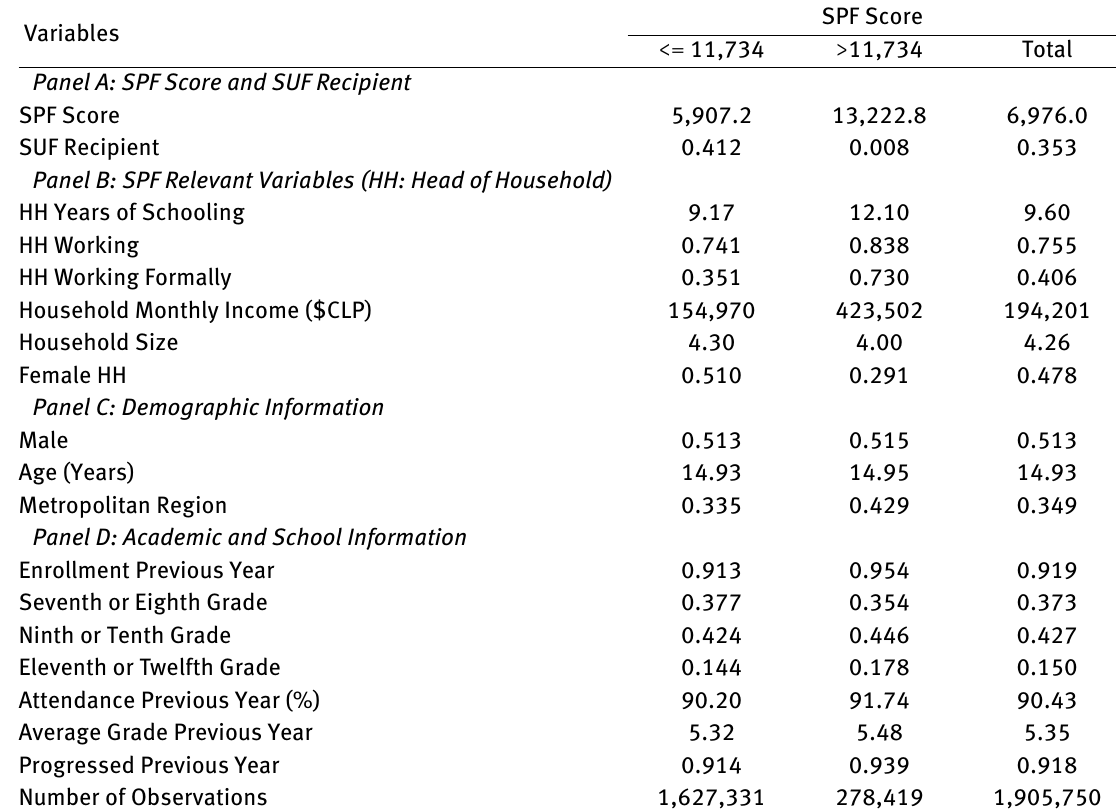
Table 7: Descriptive Statistics (Mean Values) by SUF Threshold